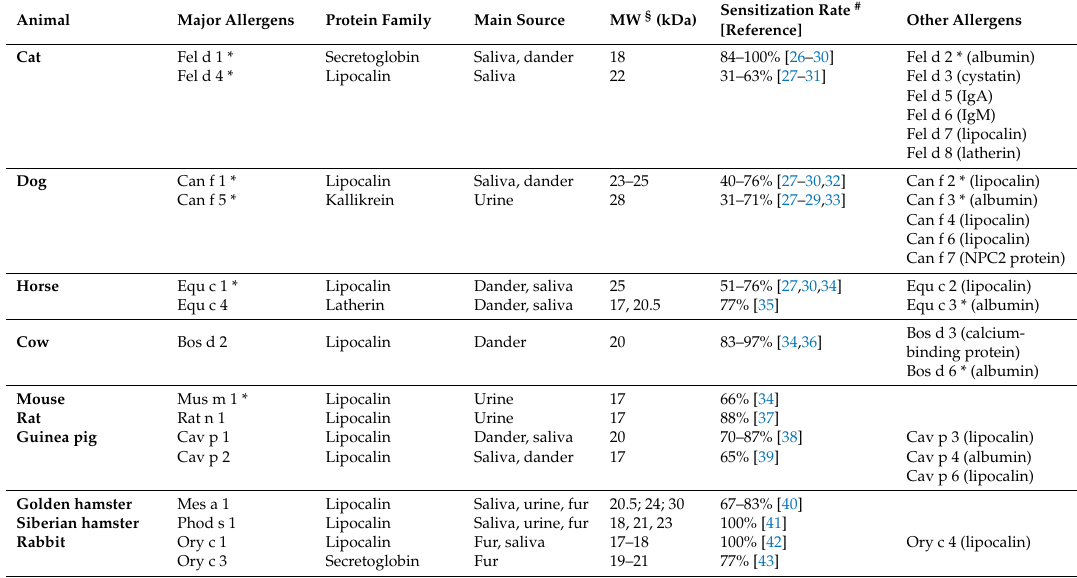
Table 1. Characterized inhalant mammalian allergens (listed in the WHO/IUIS allergen database